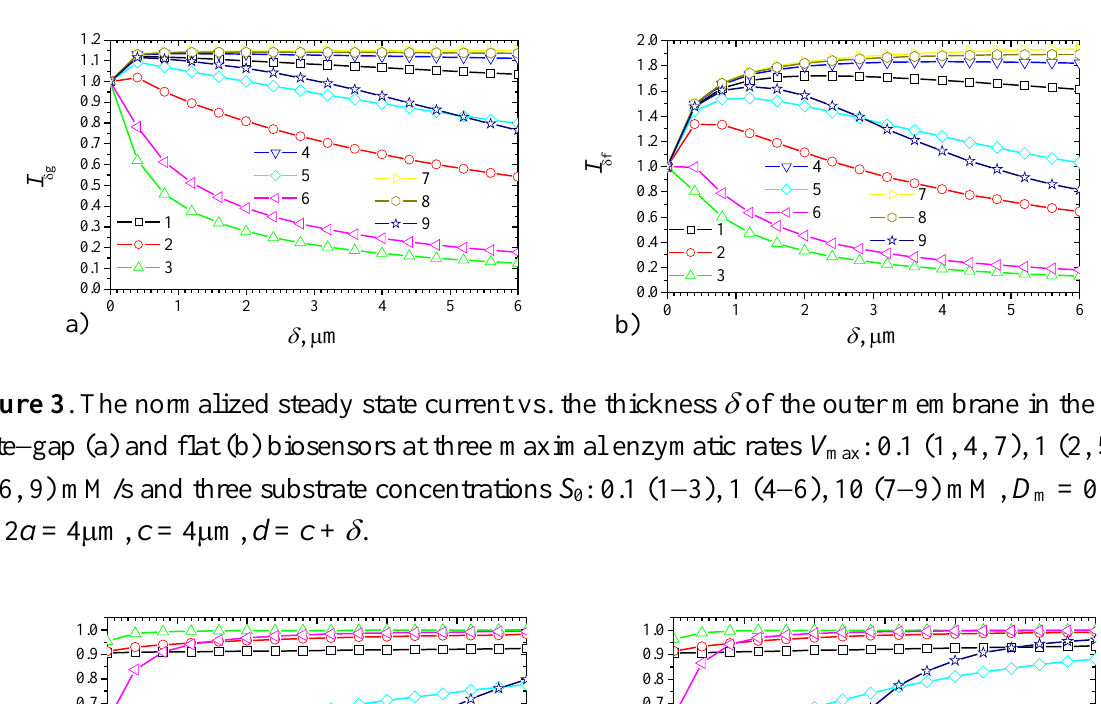
: 0.1 (1, 4, 7), 1 (2, 5, 8), 10 max : 0.1 (1 − 3), 1 (4 − 6), 10 (7 − 9) mM, D = 0.1 µ m 2 /s, 0 m